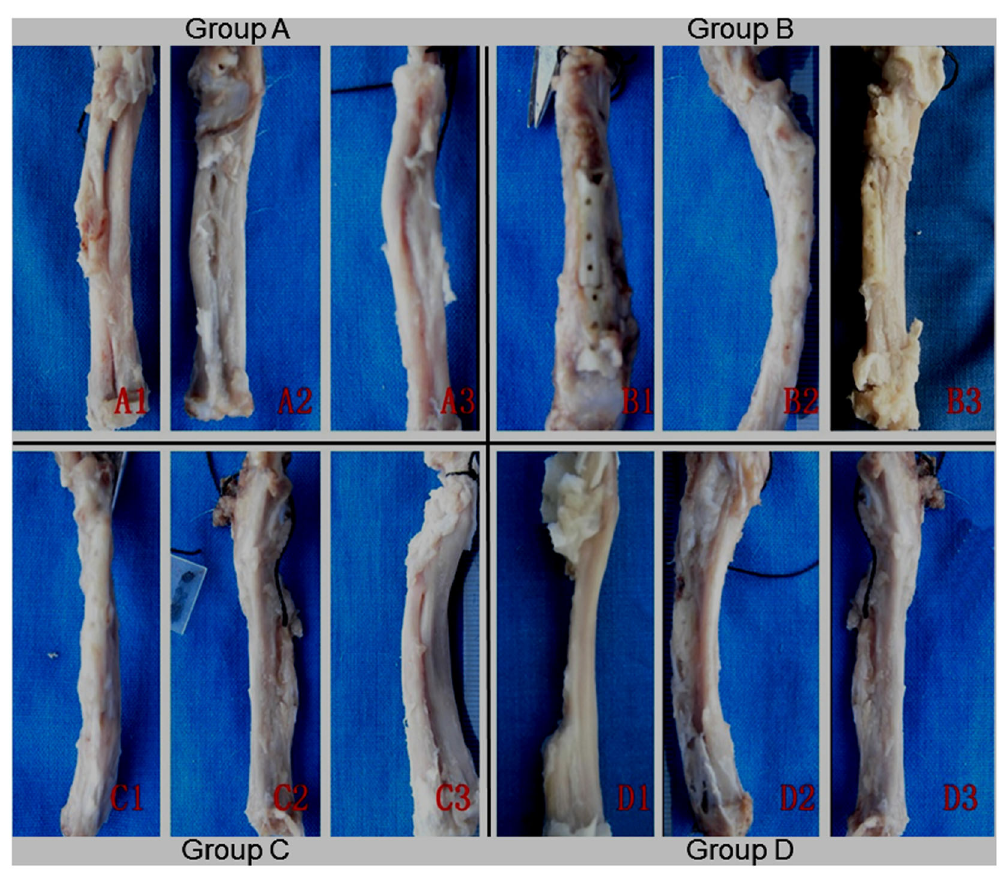
Fig. 4 Macroscopic view of bone defects repair in Group A at 4 weeks ( A1 ), 8 weeks ( A2 ) and 12 weeks ( A3 ); in Group B at 4 weeks ( B1 ), 8 weeks ( B2 ) and 12 weeks ( B3 ); in Group C at 4 weeks ( C1 ), 8 weeks